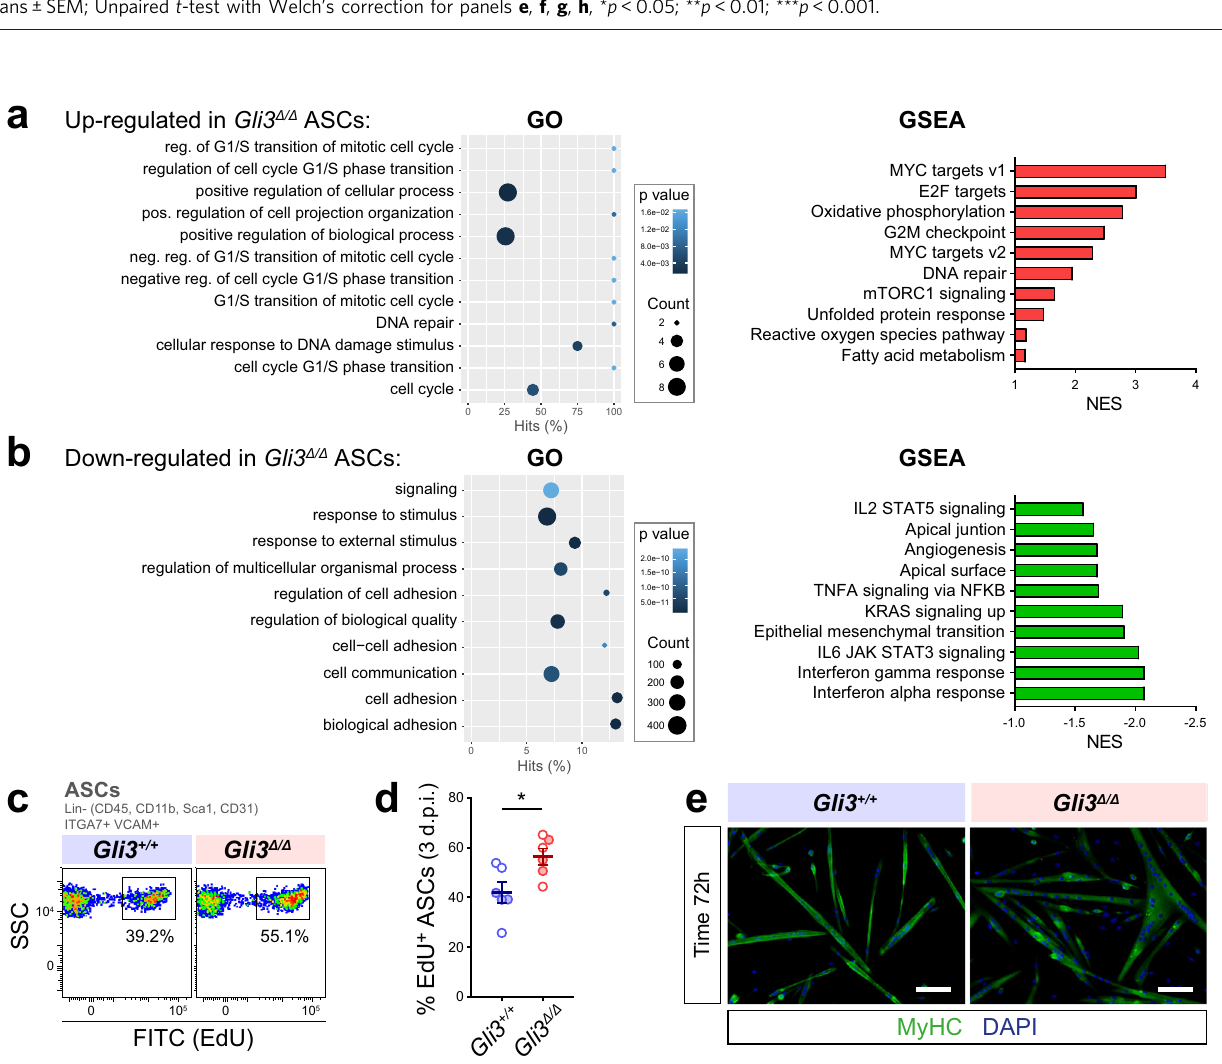
Fig. 6 Gli3 deletion allows for the expansion of the satellite cell pool. a Gene Ontology (GO) term enrichment (Biological process) and gene set enrichment analysis (GSEA) for the upregulated and b downregulated genes in Gli3 Δ / Δ ASCs compared to Gli3 + / + ASCs. c Representative fl ow cytometry plot of Gli3 + / + and Gli3 Δ / Δ ASCs that have incorporated EdU. d Proportion of EdU + Gli3 + / + and Gli3 Δ / Δ ASCs isolated from injured muscles at 3 days post-injury (d.p.i.) ( n = 3 males, empty dots, and three females, colored dots). Means ± SEM; Unpaired t -test with Welch ’ s correction, * p < 0.05. e Representative immunostaining of myosin heavy chains (MyHC, green) of 72-h-differentiated Gli3 Δ / Δ and Gli3 + / + myoblasts. DAPI (blue) stains nuclei. Scale bar, 100 µ (Supplementary Fig. 6b). However, GSEA revealed mTORC1- signaling among the activated pathways in Gli3 Δ / Δ ASCs (Fig. 6a), which promotes satellite cell proliferation, differentiation, and fusion upon activation 38 – 40 .